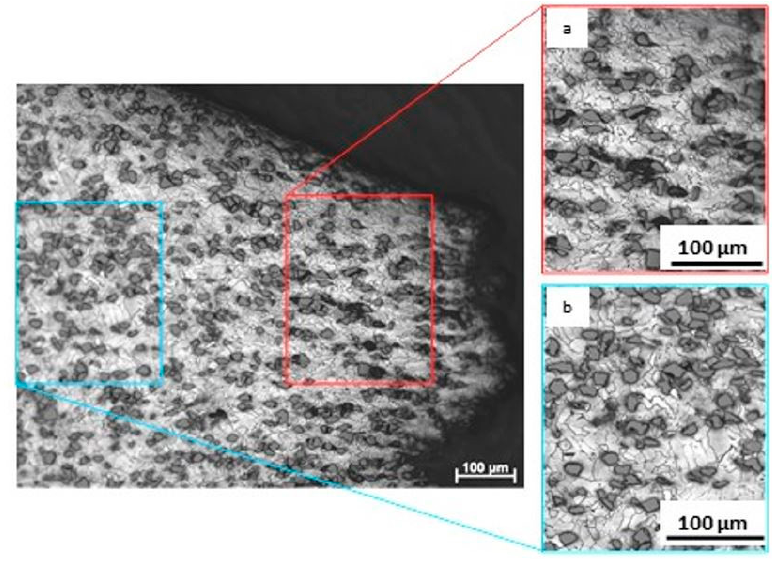
Figure 15. Light microscopy image, longitudinal section, Ti-MMC, ( a ) recrystallized microstructure, ( b ) unchanged microstructure of the matrix.